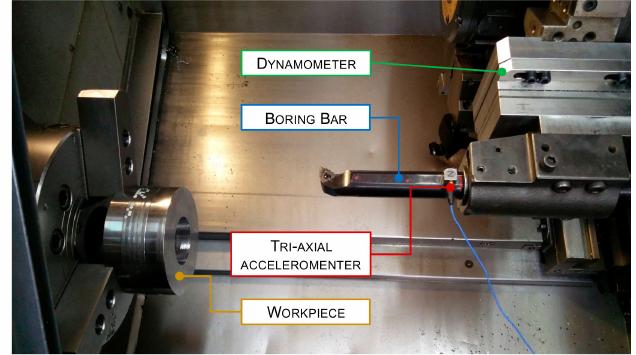
Figure 10. Experimental setup for chatter